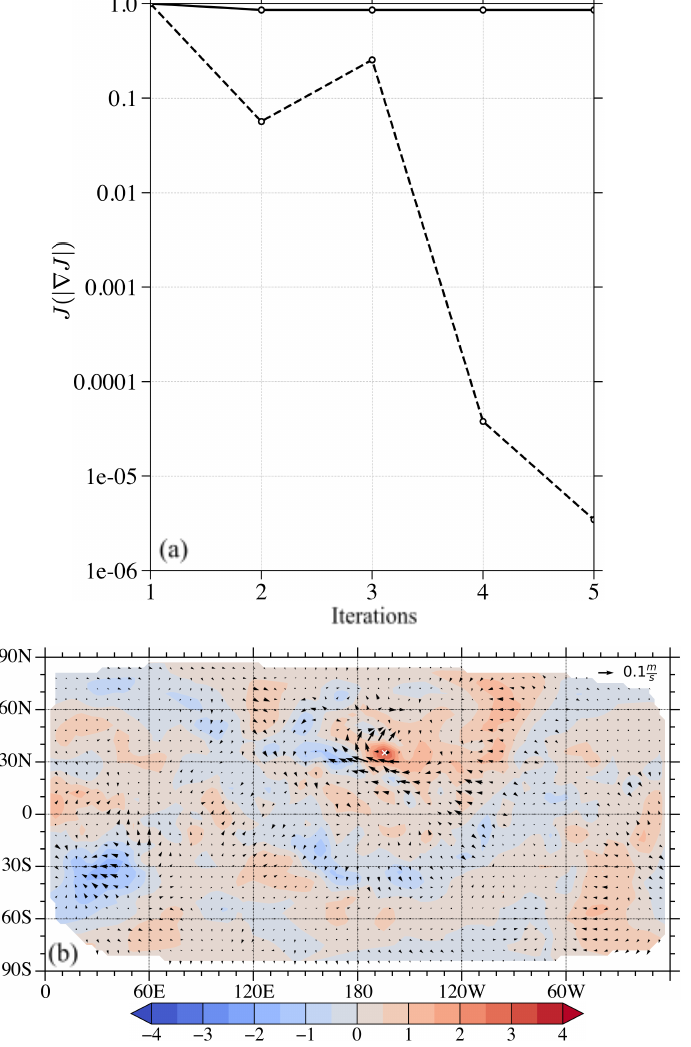
Figure 6. ( a ) Variation of the cost function (solid curve) and the norm of the gradient (dashed curve) with respect to the number of iterations when assimilating a single point observation. ( b ) The analysis increment in height (shaded) and wind (vectors) after assimilating only the height at the location marked with a white cross.